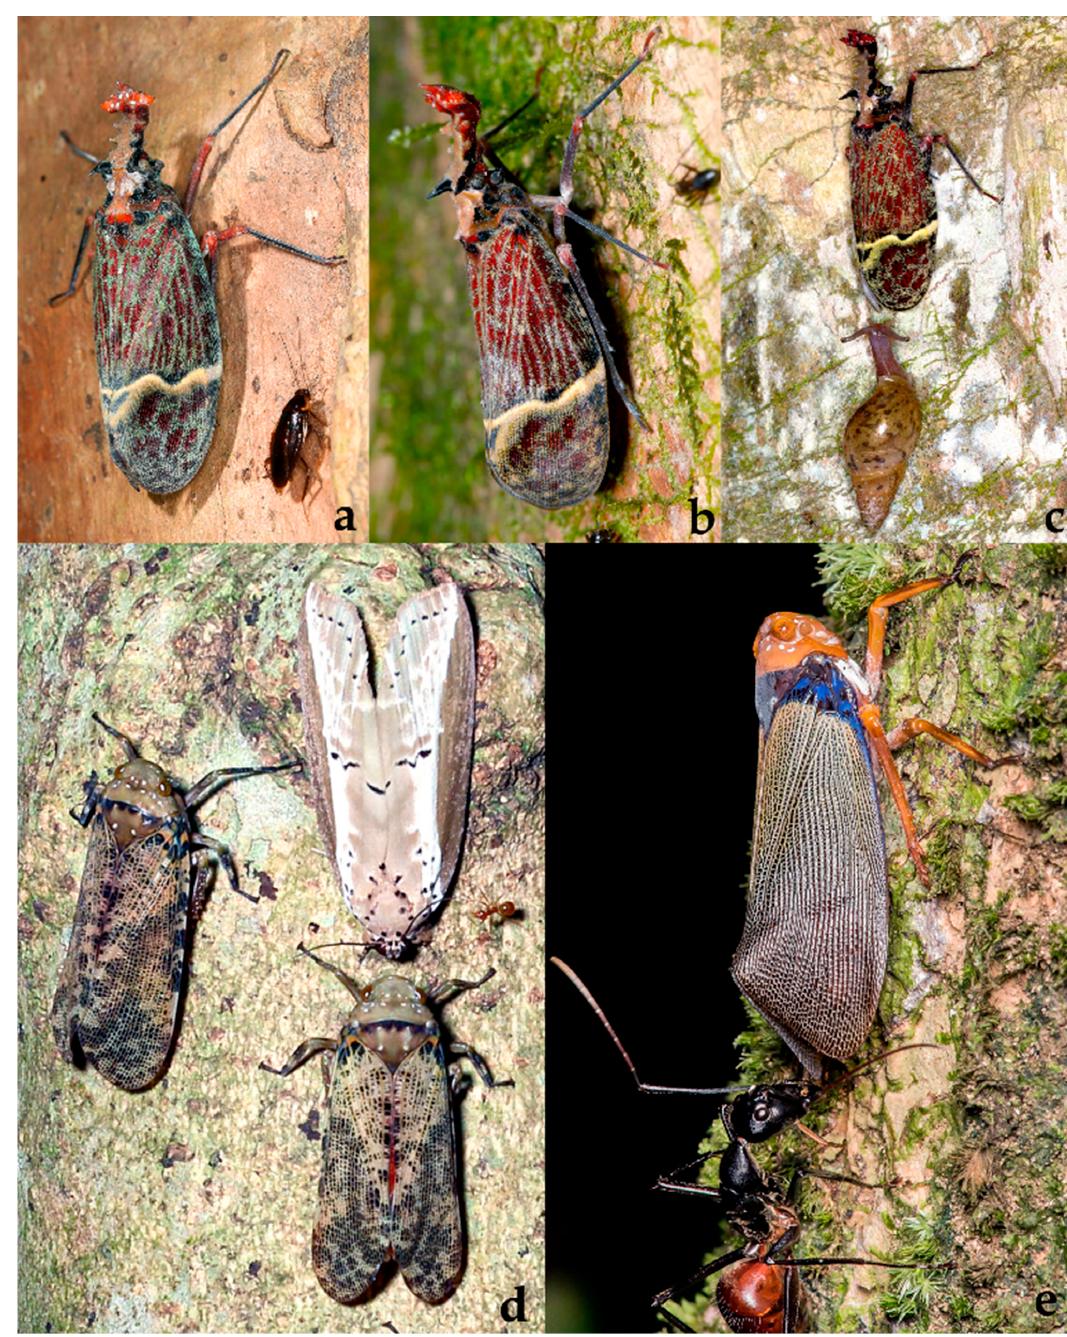
Figure 15. Fulgoridae: ( a ) Phrictus quinquepartitus Distant, 1883 tended by Blattodea indet., Costa Rica: Guanacaste, San Jorge, 10°44 ′ 2.23 ″ N 85°18 ′ 2.03 ″ W, 617 m, 01.03.2018, adult on tree trunk, obs. G. Kunz; ( b ) P. quinquepartitus tended by Formicidae: Formicinae: Camponotus sp., Costa Rica: La Selva Biological Station, 10°25 ′ 42.9 ″ N 84°00 ′ 16.0 ″ W, 04.02.2016, adult, obs. G. Kunz; ( c ) P. quinquepartitus tended by Gastropoda: Spiraxidae: Euglandina sp., Costa Rica: Puerto Viejo de Sarapiquí, La Selva Biological Station, 10°25 ′ 49.97 ″ N 84° 0 ′ 18.36 ″ W, 53 m, 02.02.2016, adult on tree trunk, obs. G. Kunz; ( d ) Polydictya thompsoni Constant and Pham, 2019 tended by Lepidoptera: Nolidae: Eligma narcissus (Cramer, 1775), Thailand: Ratchaburi province, Suan Phueng district, 30.10.2020, adults on tree trunk, obs. K. Jiaranaisakul; ( e ) Polydictya sp. tended by Formicidae: Formicinae: Dinomyrmex gigas (Latreille, 1802), Singapore, 1°17 ′ N 103°50 ′ E, 19.10.2016, adult on tree trunk, obs. C. Nijhuis.